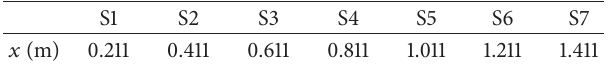
Table 2: Locations of cross sections. Table 3: Comparison of 𝐿 ’s between experiments and